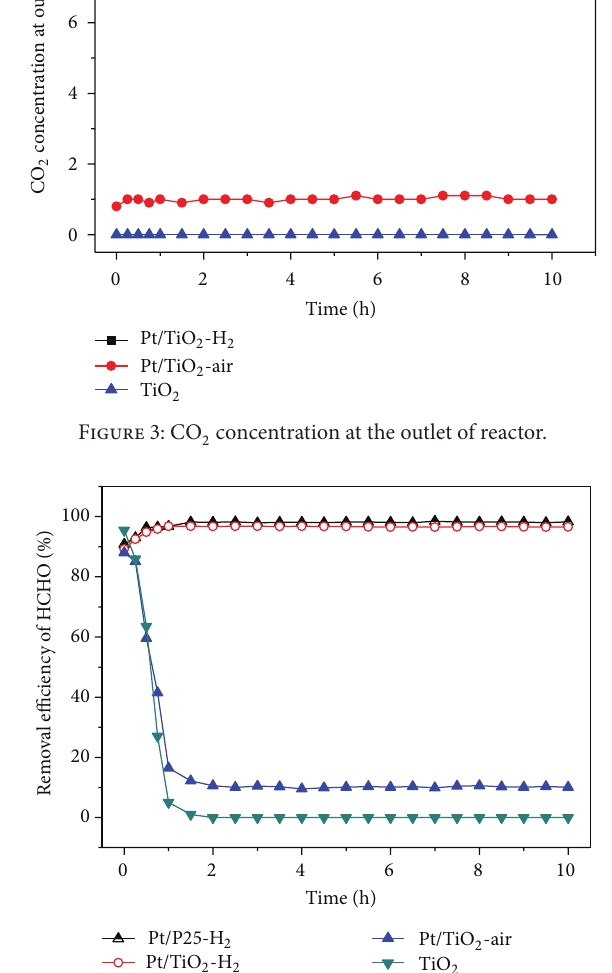
Figure 4: HCHO removal efficiency over the Pt/TiO 2 and TiO 2 cat-